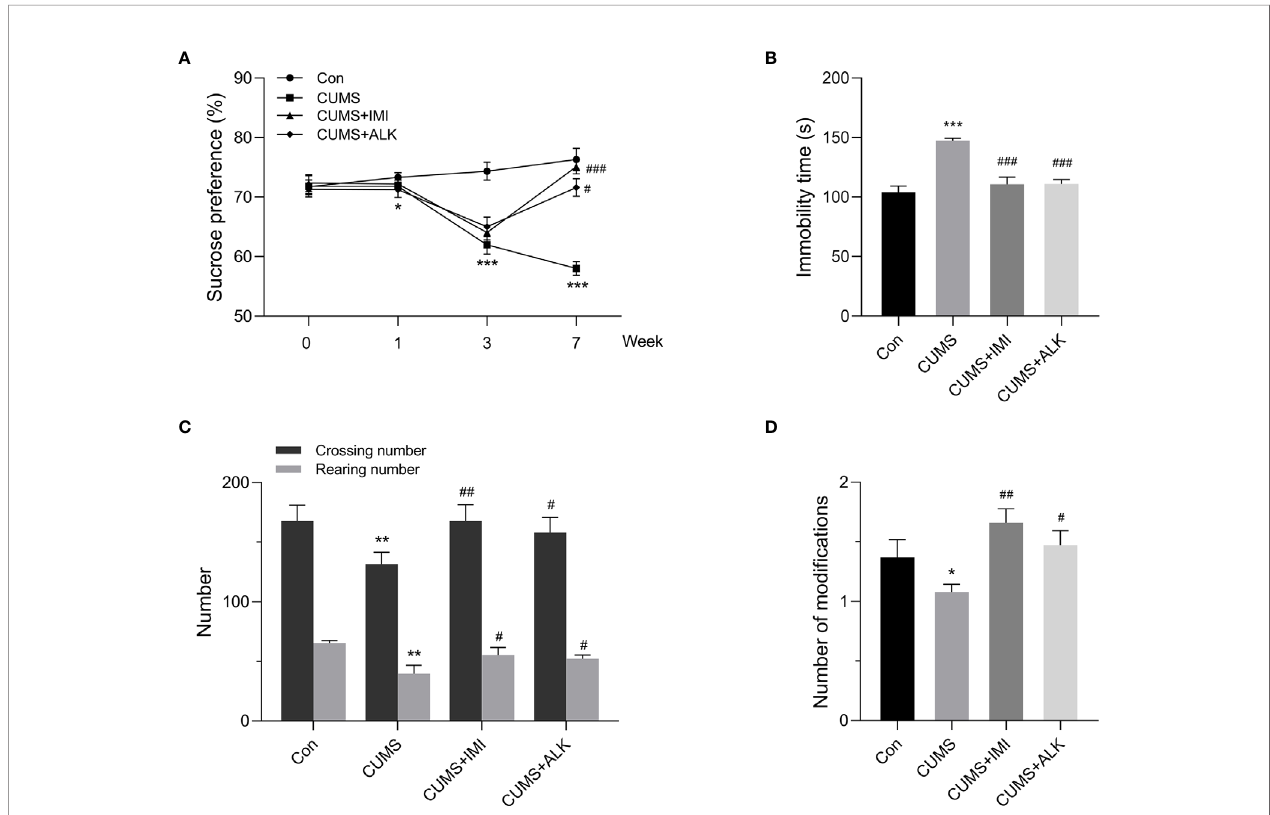
FIGURE 2 | Effect of alkaloids on depression-like behaviors. (A) Sucrose preference in the SPT. (B) Immobility time in the FST. (C) The number of crossings and rearings in the OFT. (D) The number of modi fi cations in the OFT. Data are presented as the mean ± SD. * P < 0.05, ** P < 0.01, *** P < 0.001 versus the control group (Con); # P < 0.05, ## P < 0.01, ### P < 0.001 versus the CUMS